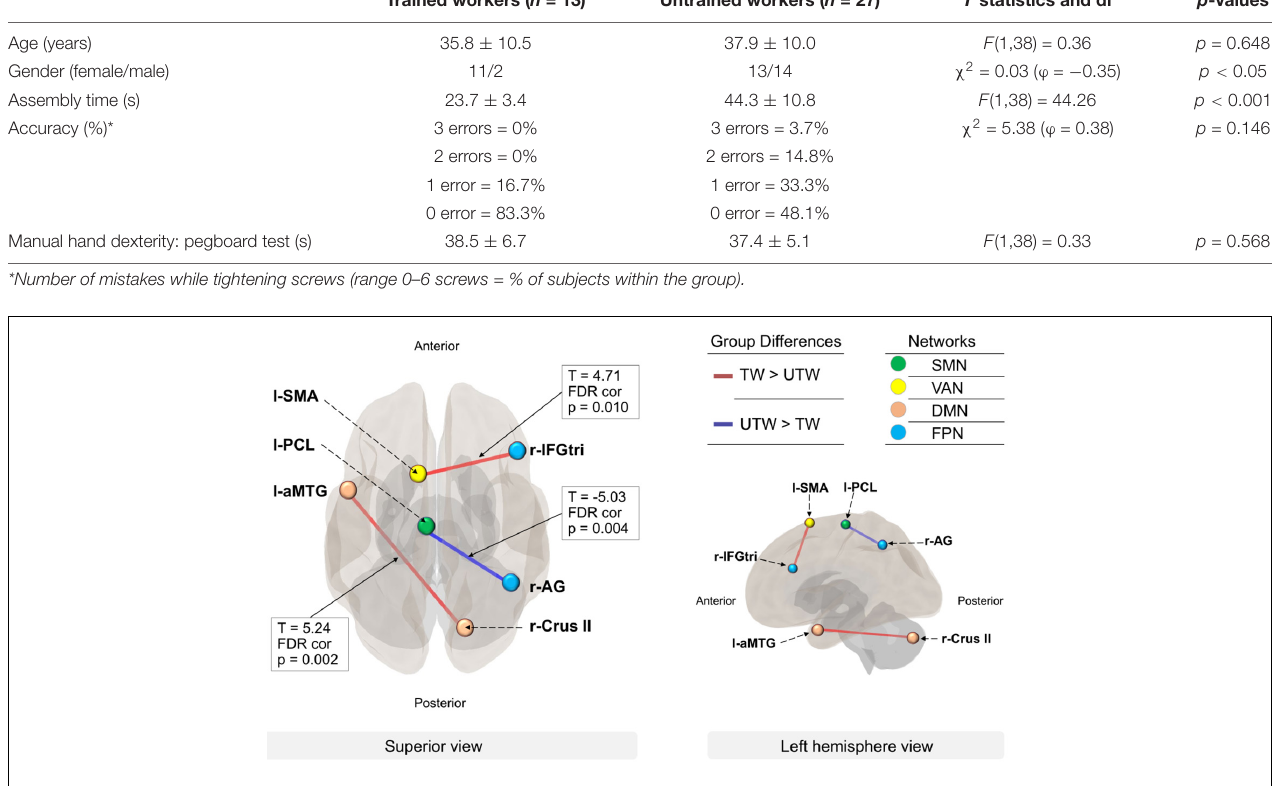
FIGURE 2 | Between-network connectivity in TW and UTW. The lines represent the functional connectivity with other ROIs (FDR-corrected, p < 0.01). Group differences: red lines represent higher connectivity in TW than in UTW (TW > UTW); blue lines represent higher connectivity in UTW than in TW (UTW > TW). Networks: colored dots indicate the four networks with significance at p < 0.01. Green, somatomotor hand network (SMN); yellow, ventral attention network (VAN); pink, default mode network (DMN); light blue, fronto-parietal network (FPN). ROIs: l-aMTG, left anterior middle temporal gyrus; r-Crus II, right cerebellum crus II; l-SMA, left supplementary motor area; r-IFGtri, pars triangularis of the right inferior frontal gyrus; l-PCL, left paracentral lobule; r-AG, right angular